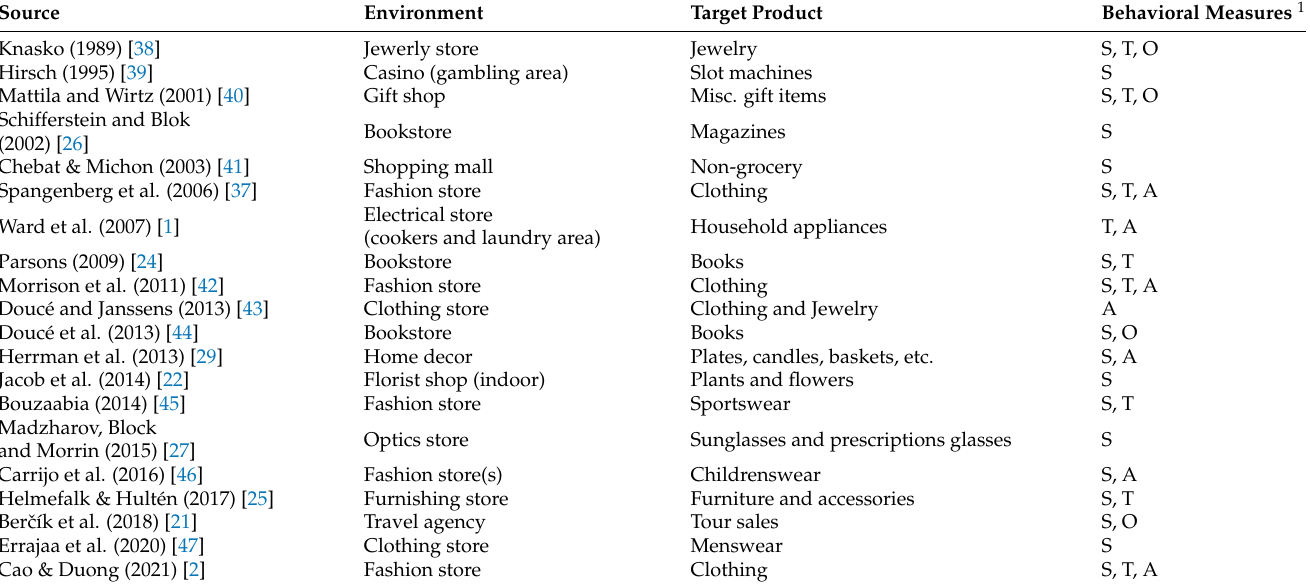
Table 1. Overview of the literature included in this review, listed chronologically. 1 S = Sales volume, T = Dwell time, A = Attitude survey, O =